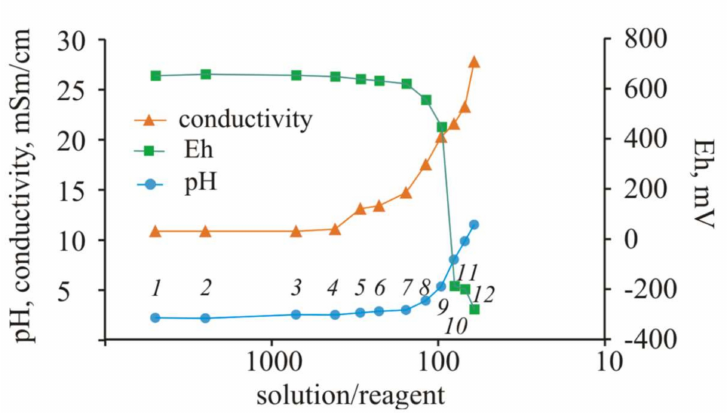
Figure 8. Changes in the physicochemical conditions and EC during the experiment with NaOH. S / R ratio decreased as follows: 1 —5000; 2 —2500; 3 —714; 4 —417; 5 —294; 6 —227; 7 —156; 8 —119; 9 —96; 10 —81; 11 —69; 12